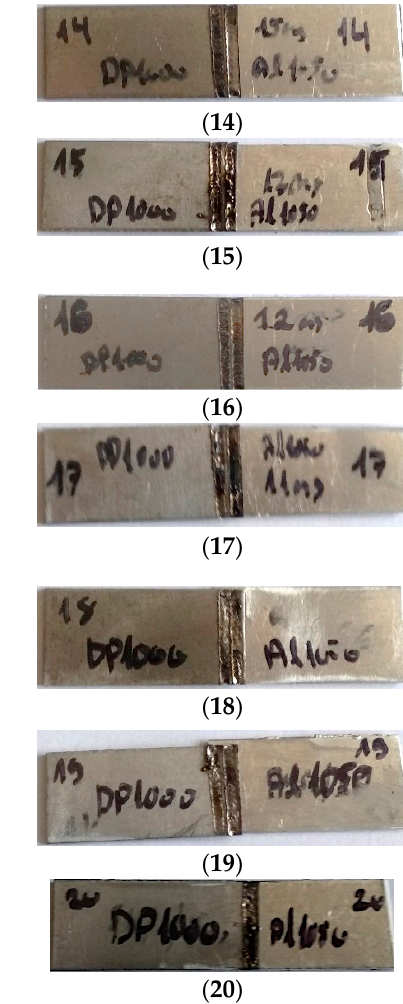
Figure 9. Steel-aluminum welded samples.